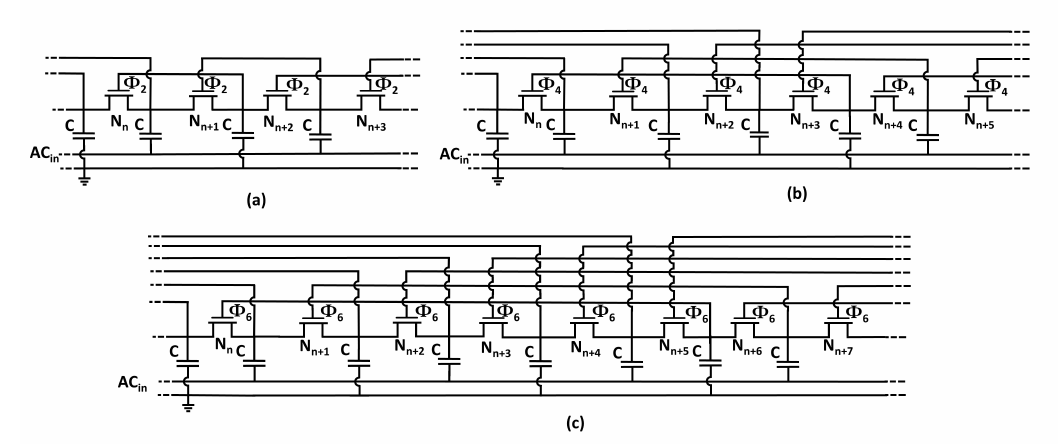
Figure 6. Generalized representation of a voltage multiplier with ( a ) a second order of compensation,